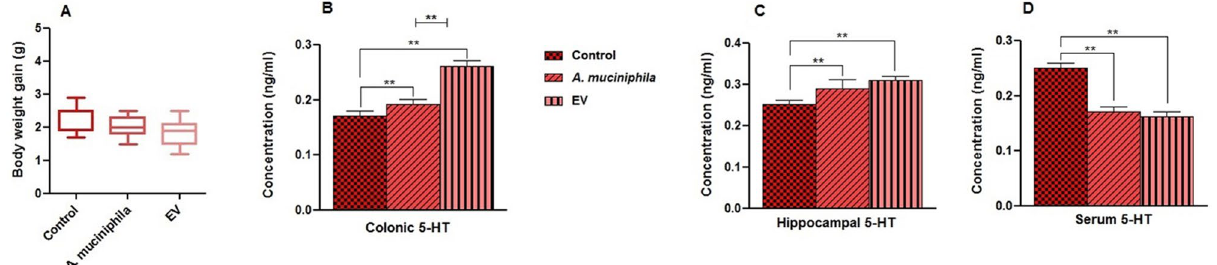
Figure 2. Effects of treatment with A. muciniphila and its EVs on the body weight and level of serotonin. This figure indicates the body weight ( A ) and level of serotonin released from ( B ) colon, ( C ) hippocampus, and ( D ) serum of mice. Data are standardized relative to the expression level of the control group (*P < 0.05 and **P < 0.01 are considered statistically